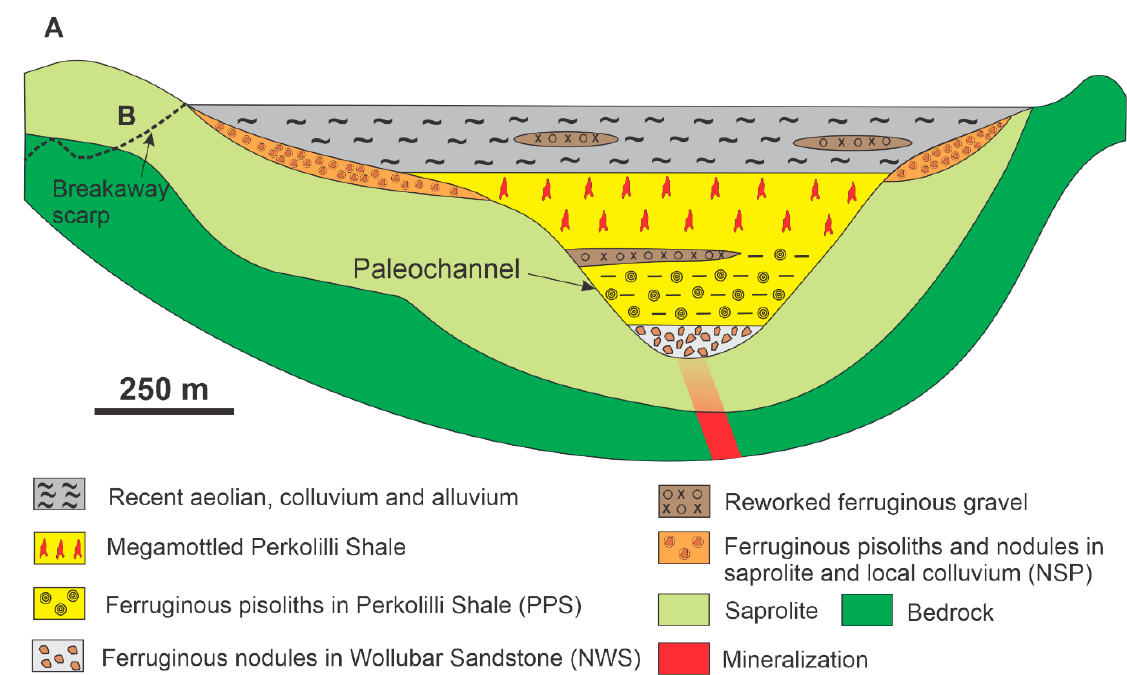
Figure 1. Schematic cross-section showing regolith-landform relationships typical of the Yilgarn Craton. Ferruginous nodules and pisoliths occur on the flanks, middle and bottom of the paleochannel (see text for detailed explanation). ( A ) Where there has been minimal or no erosion of upland weathered bedrock, ferruginous nodules and pisoliths are found typically downslope from subdued weathered bedrock hills. ( B ) Where upland weathered bedrock has been eroded, resistant duricrust forms high breakaway scarps typical of granitic terrain. The cross section is approximately 2 km across in east-west direction.